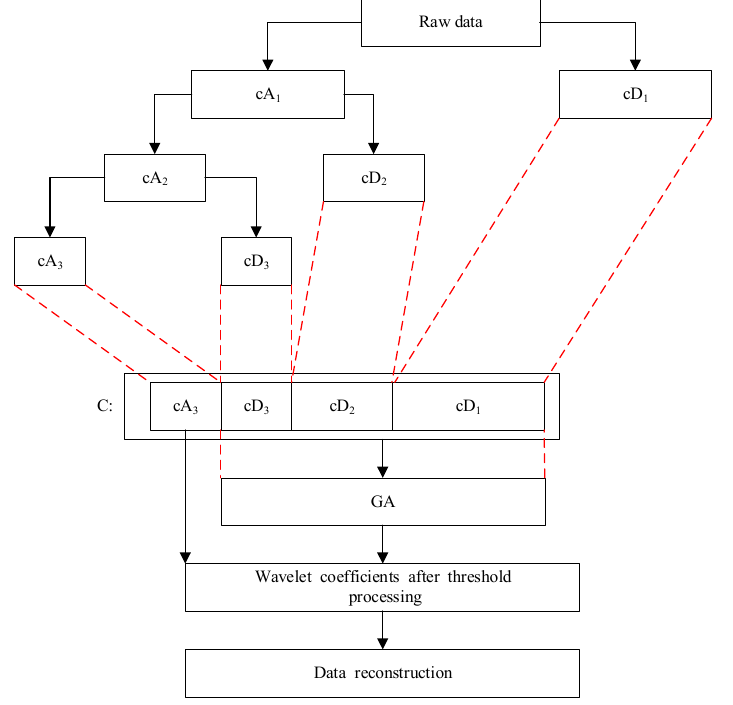
Figure 3. GA-WT noise reduction process.